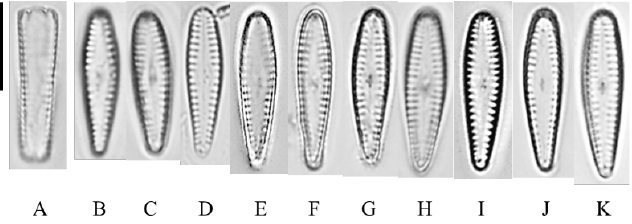
Figure 6. Light microscope photo of Gomphonema seminulum sp. nov. taken from holotype popula-